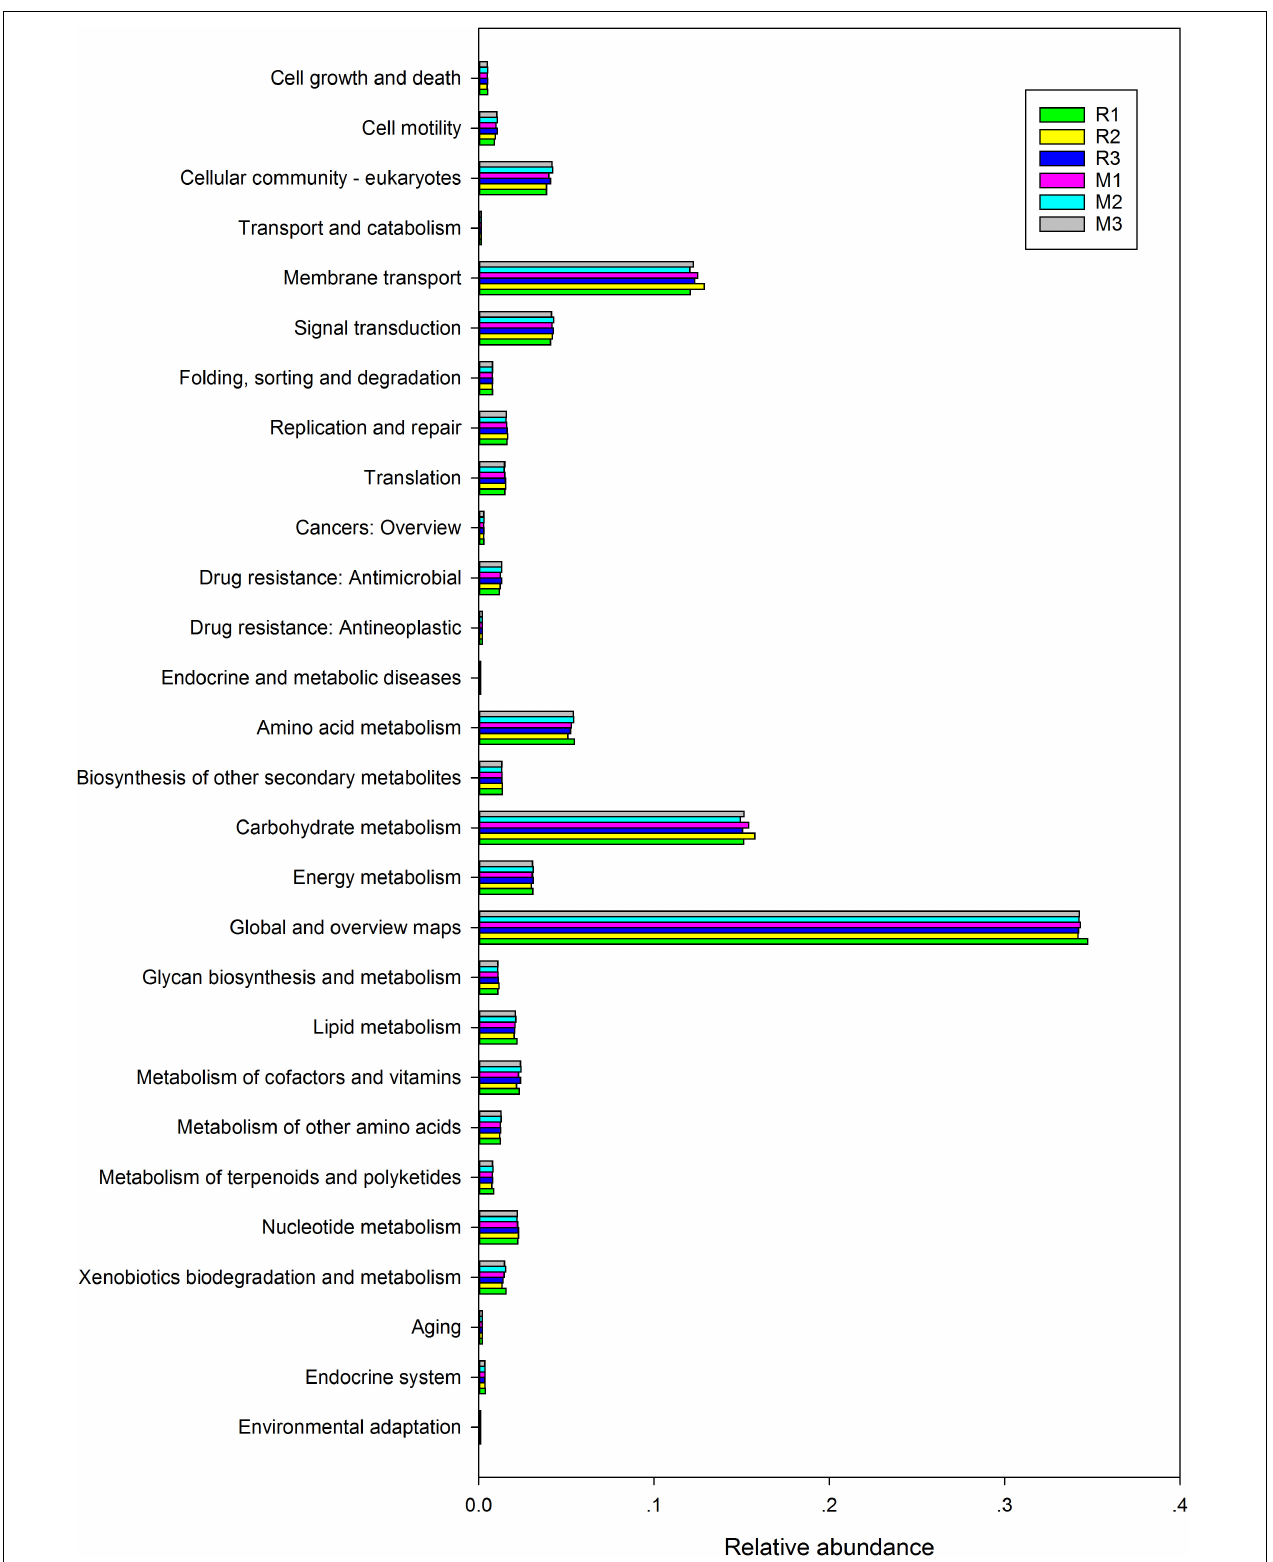
FIGURE 9 | Comparison of predicted GO functions of the gut bacteria of C. medinalis fed different host plants for three generations.